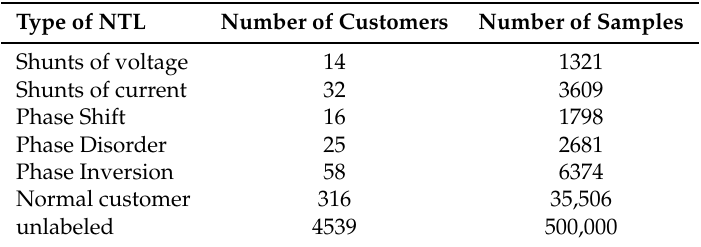
Table 2. Brief information of